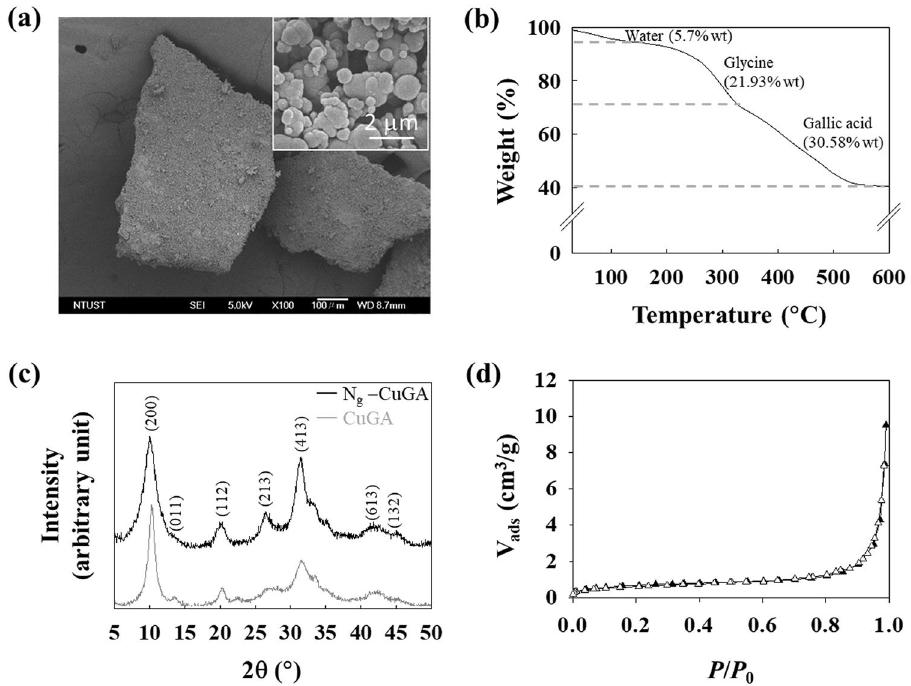
Figure 2. ( a ) FE-SEM of N g -CuGA with bulky shape, inset figure show spherical-like particles at 5000 × magnification. ( b ) TGA, ( c ) powder X-ray diffraction, and ( d ) nitrogen adsorption–desorption isotherm of N g -CuGA.